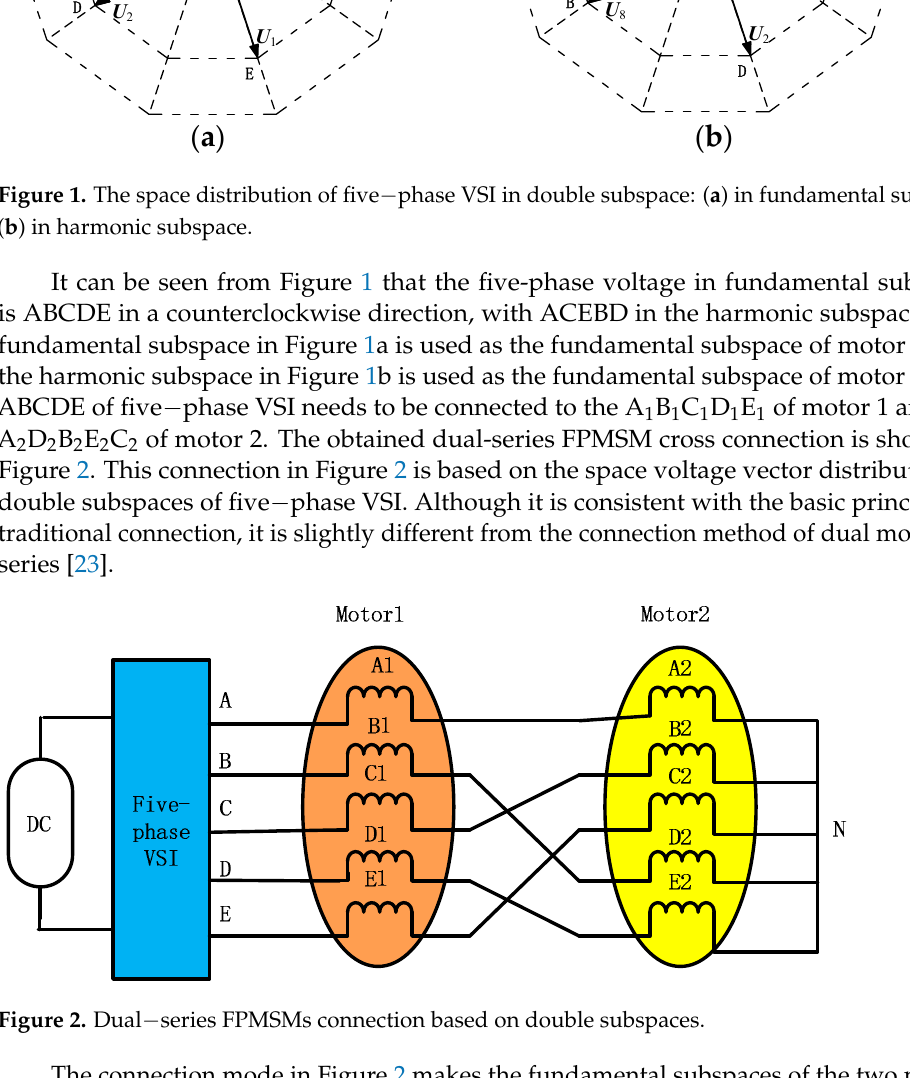
Figure 2. Dual − series FPMSMs connection based on double subspaces. The connection mode in Figure 2 makes the fundamental subspaces of the two motors correspond to the fundamental subspaces and harmonic subspaces of the five − phase VSI,